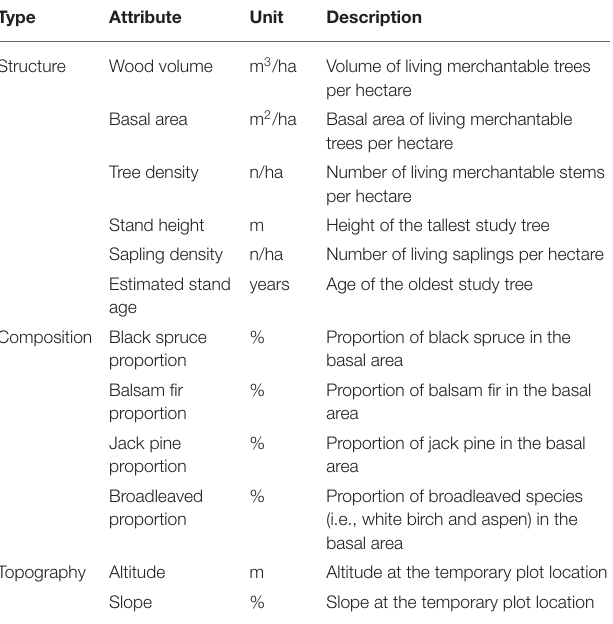
TABLE 1 | Attributes computed for the temporary plots composing the studied